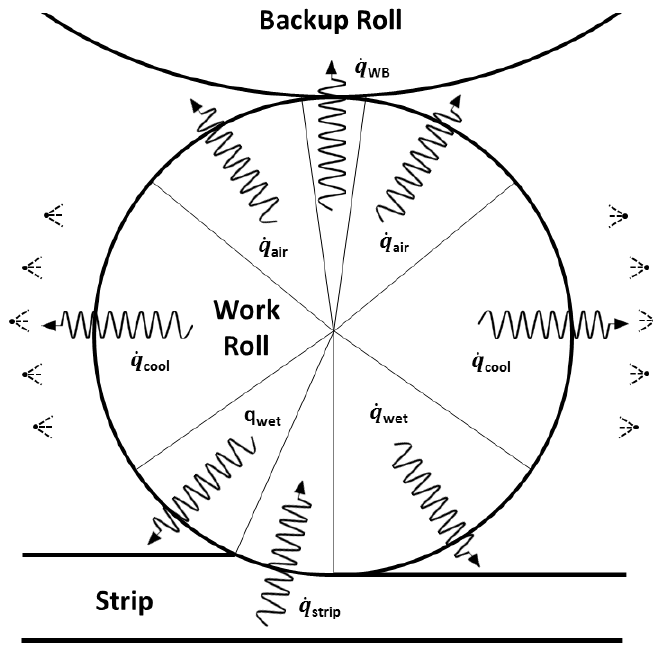
Figure 1. Schematic illustration of the zones with the different boundary conditions.